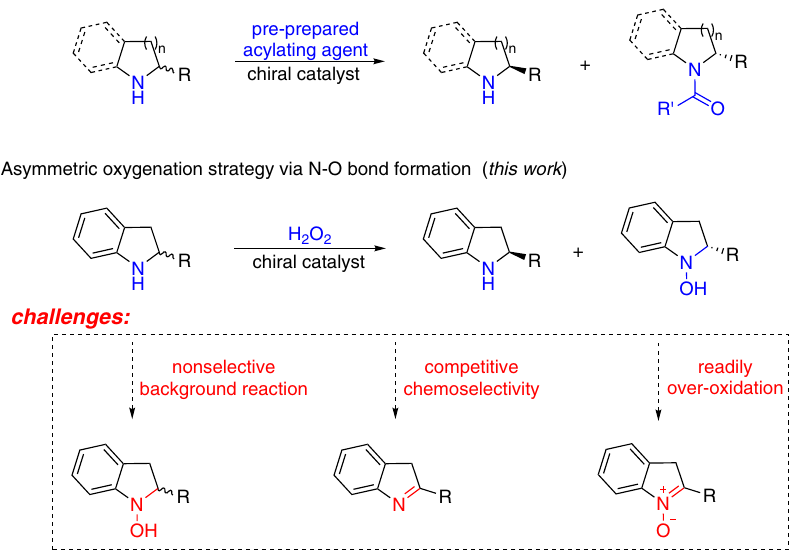
Fig. 1 Overview of KR of cyclic secondary amines. a Asymmetric acylation strategy via N – C bond formation. b Asymmetric oxygenation strategy via N – O bond